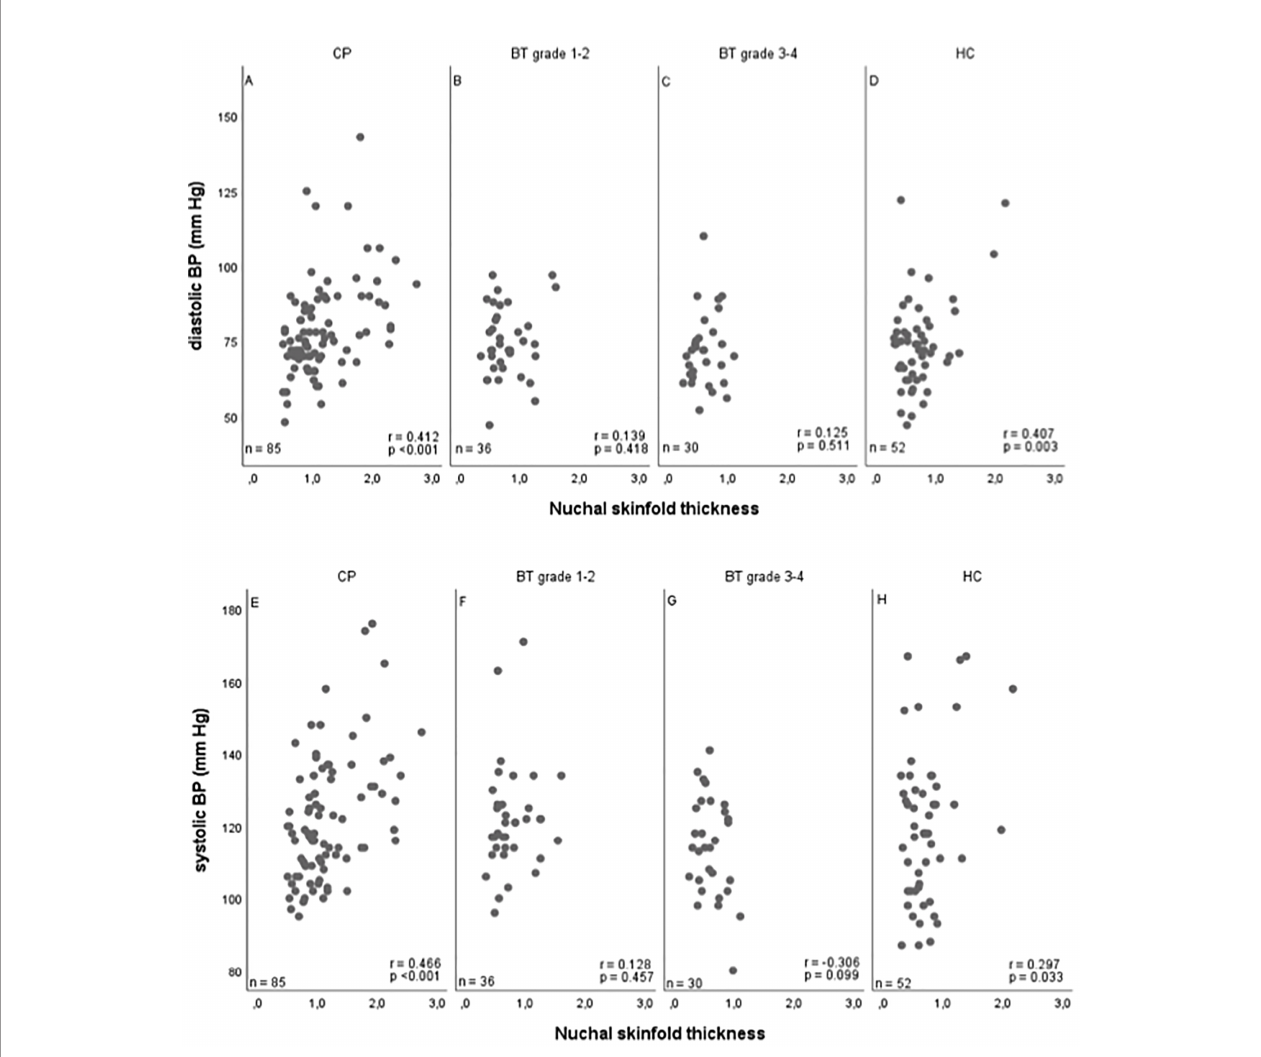
FIGURE 4 | Correlations between nuchal skinfold thickness (NST) as measured (cm) on cranial magnetic resonance imaging (MRI) and diastolic (A – D) and systolic (E – H) blood pressure (BP) (mm Hg) in patients with childhood-onset craniopharyngioma (CP) (A, E) , WHO grade 1 or 2 brain tumor (BT) patients (B, F) , WHO grade 3 or 4 BT patients (C, G) , and 43 healthy controls (HC) (D, H) . r = Pearson correlation coef fi cient; mm HG, millimeter